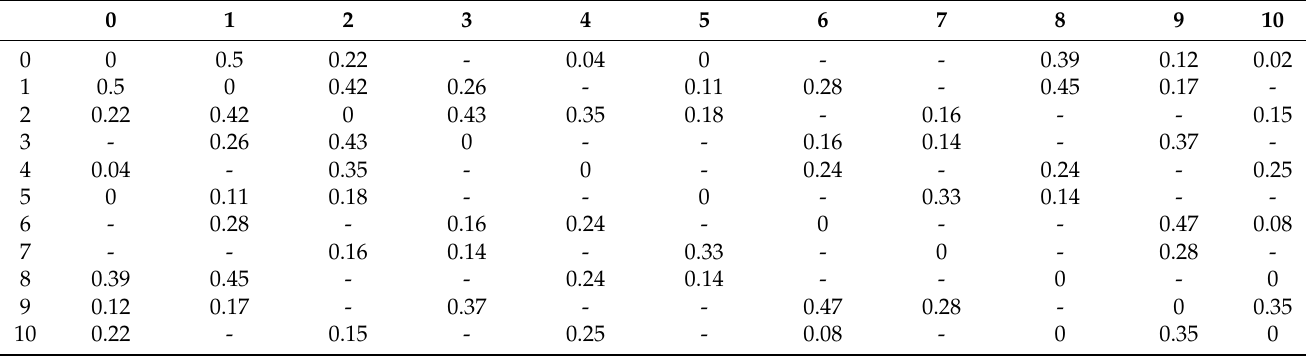
Table 7. Distribution time parameters.